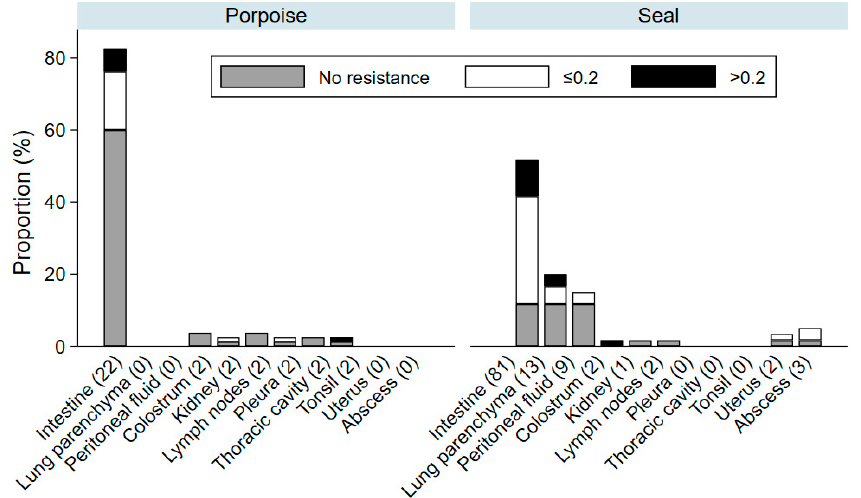
Figure 4. Proportion of bacterial isolates from harbor seals and porpoises with multipleantibiotic resistance originating from individual tissue sources. Proportions are categorized based on their Multiple Antibiotic Resistance Index (MAR): MAR = 0 (no resistance), MAR = 0 ≤ 0.2, or MAR > 0.2. Numbers in parentheses represent number of bacterial isolates from each tissue source.